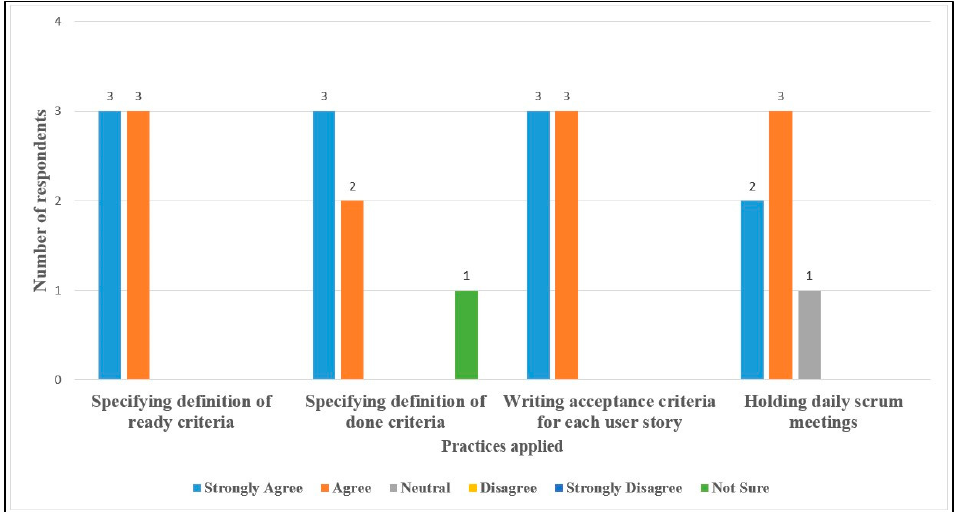
Figure 11. Summary of responses in project A.2.